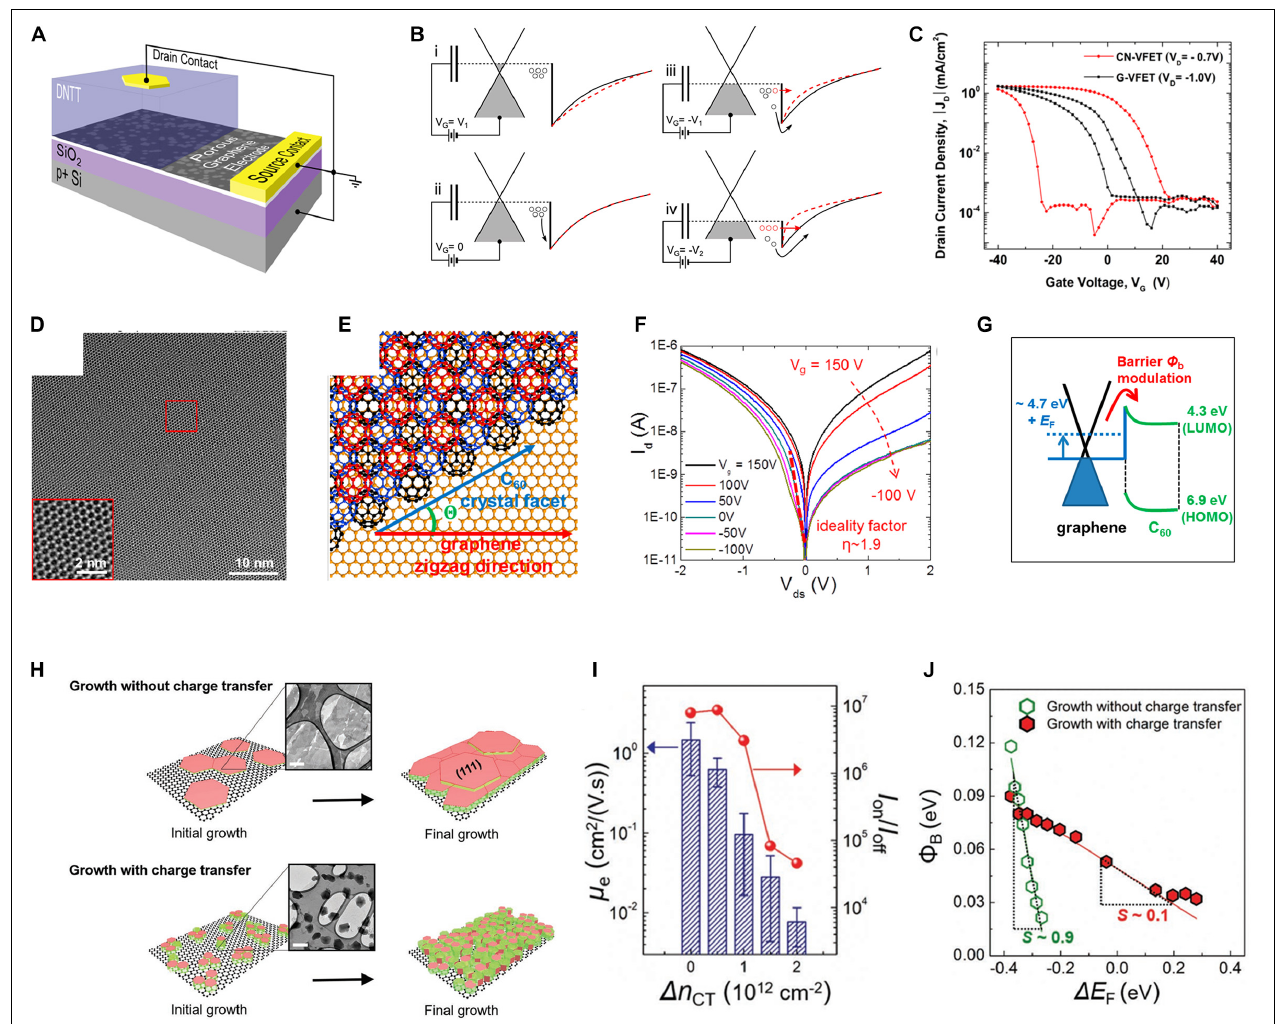
FIGURE 3 | OSCs/graphene based VFETs. (A) Device configuration of DNTT/graphene VFET. (B) Energy level diagram at the graphene-semiconducting channel interface for different bias situations. (C) Transfer curves for a CN-VFET and the G-VFET with a 20% areal hole density electrode. Reproduced from Lemaitre et al. (2012) with permission from Copyright 2012 American Chemical Society. (D) TEM image of C 60 film on graphene. (E) C 60 crystal packing on graphene. (F) Output curve with different applied gate voltages. (G) Energy diagram of the graphene/C 60 heterostructure. Reproduced from Kim et al., 2015a with permission from Copyright 2015 American Chemical Society. (H) Schematic diagram of C 60 crystal growth on graphene without (upper) and with (lower) the charge transfer between them. Insets: TEM images of corresponding graphene–C 60 samples on TEM grids. (I) Plots of transistor parameters of C 60 -FETs vs. the number of transferred electrons ( (cid:49) n CT ) during C 60 growth. (J) The Schottky barrier height ( (cid:56) B ) vs. (cid:49) E F . Reproduced from Nguyen et al. (2020) under the Creative Commons CC BY